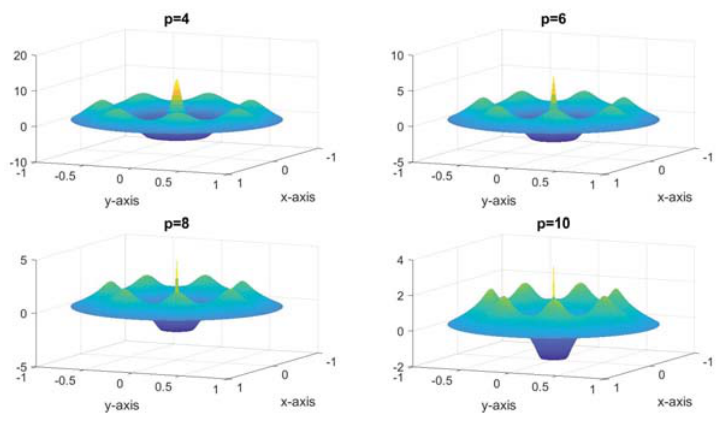
Fig. 10: Numerical solutions with three nodal regions and 7-symmetry